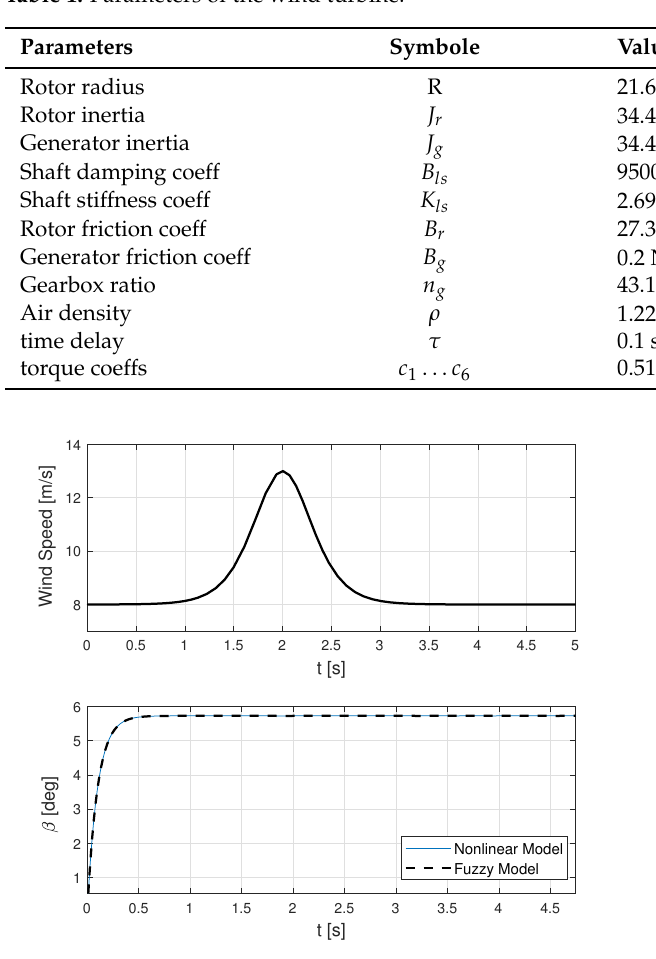
Table 1. Parameters of the wind turbine.